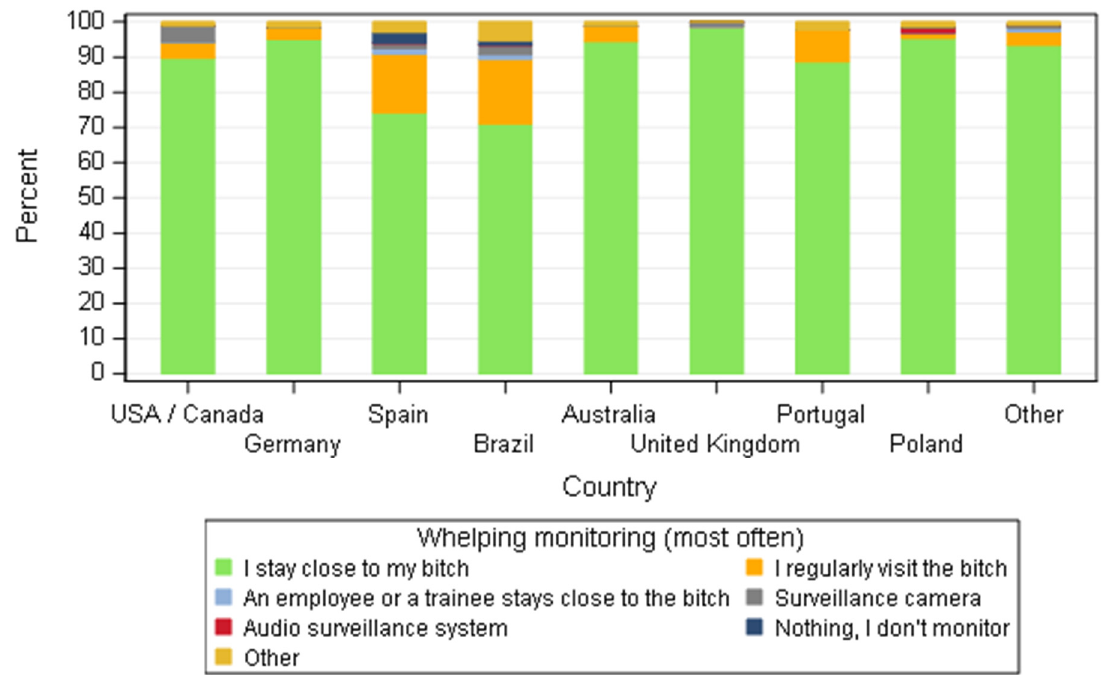
Figure 12. Distribution of the whelping-monitoring system according to dog breeders by country—all responders ( n = 668).